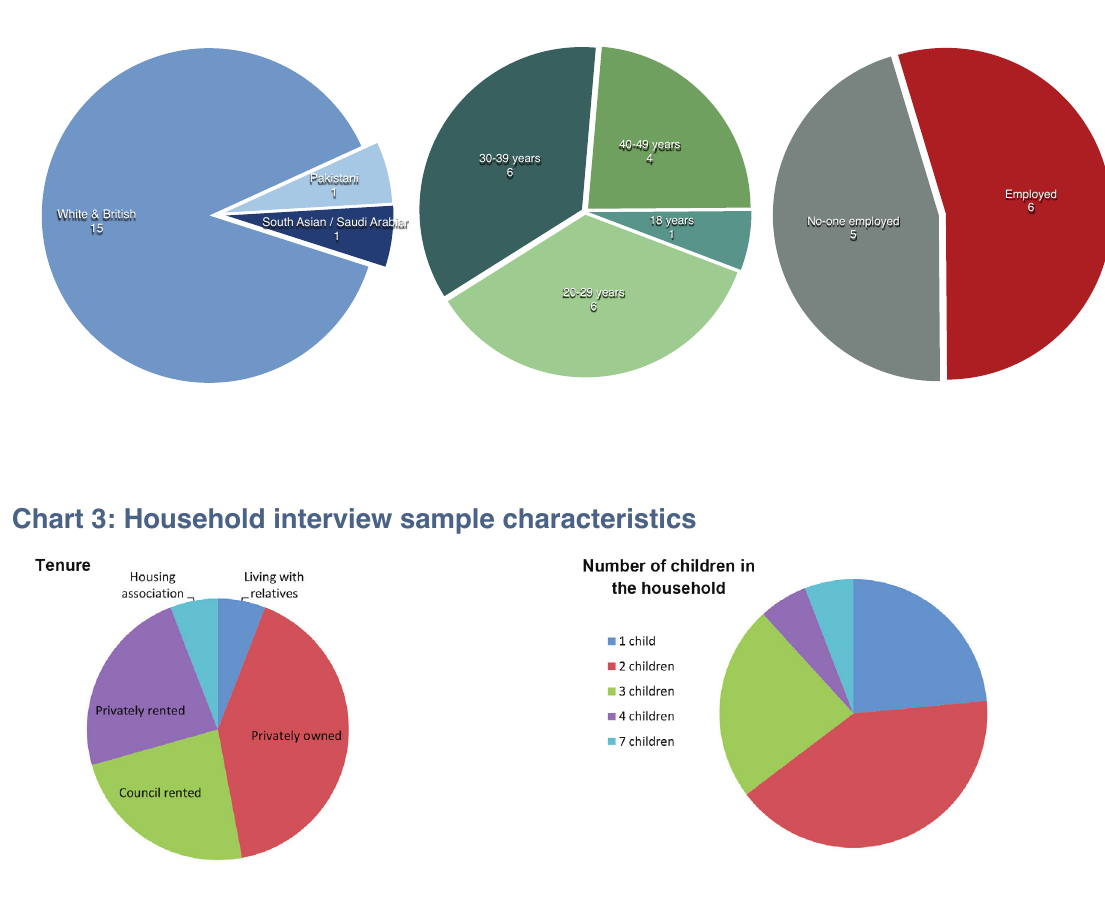
Chart 2: Household interview sample characteristics